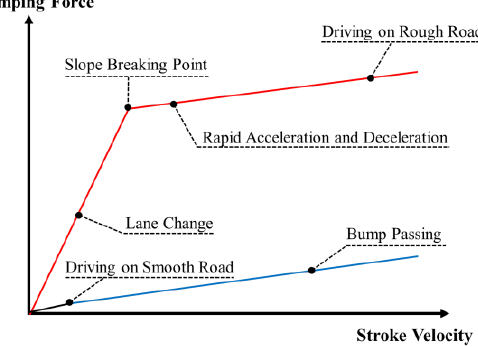
Figure 1. Optimal damping characteristics of the passive damper.